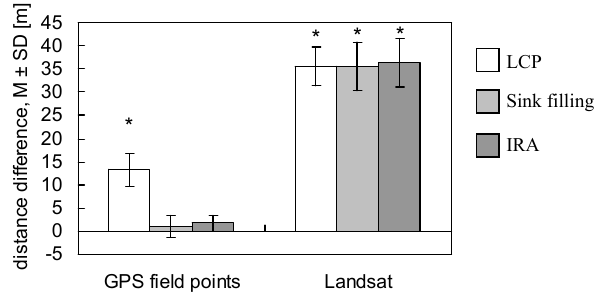
Fig. 8. Mean and standard deviation of the distance differences be- tween the 90m and the 30m SRTM DEM. A positive distance dif- ference indicates that streams extracted from the 30m SRTM DEM are closer to reference points than streams extracted from the 90m SRTM DEM. LCP: least-cost path search; IRA: impact reduction